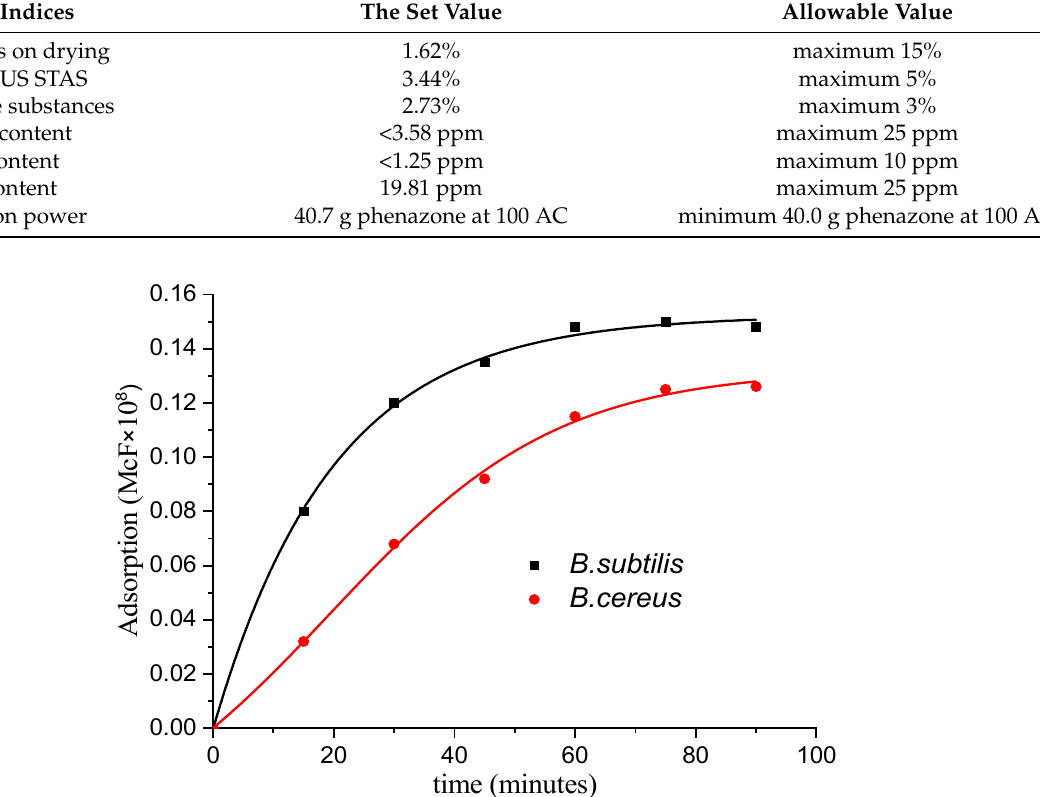
Table 2. Quality indices of the AC-A enterosorbent.